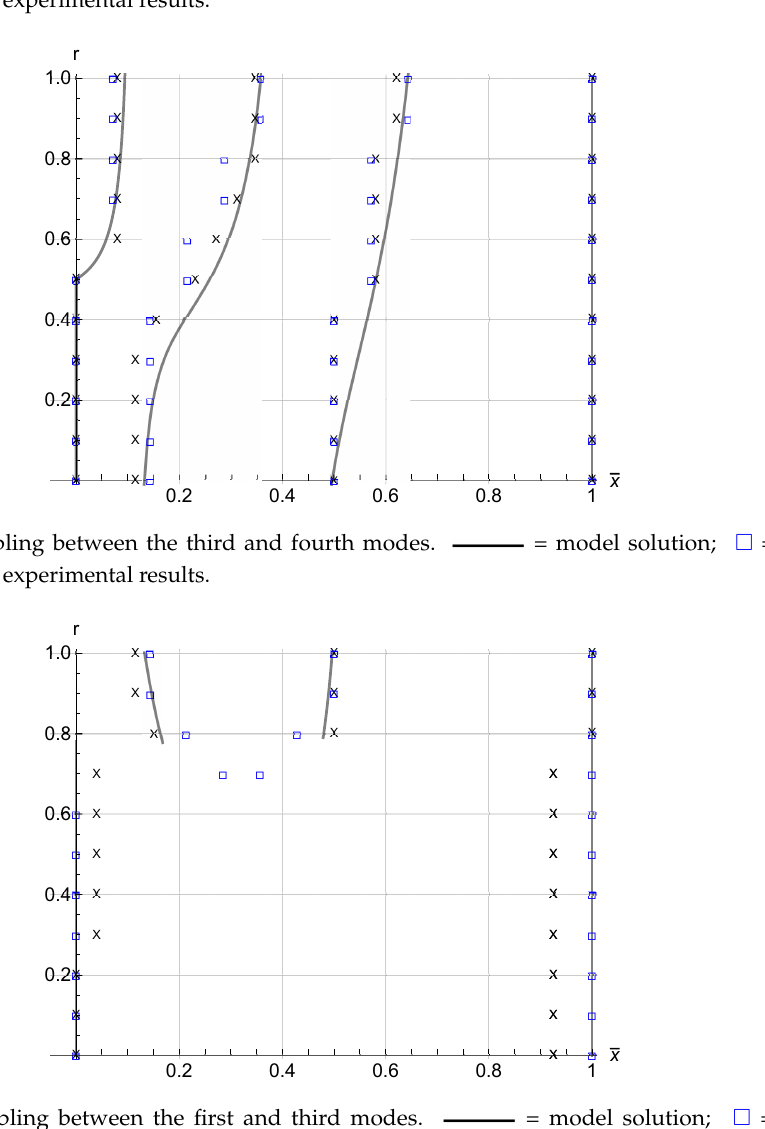
Figure 11. Coupling between the second and third modes. = model solution; (cid:3) = FEM simulations; × = experimental results.